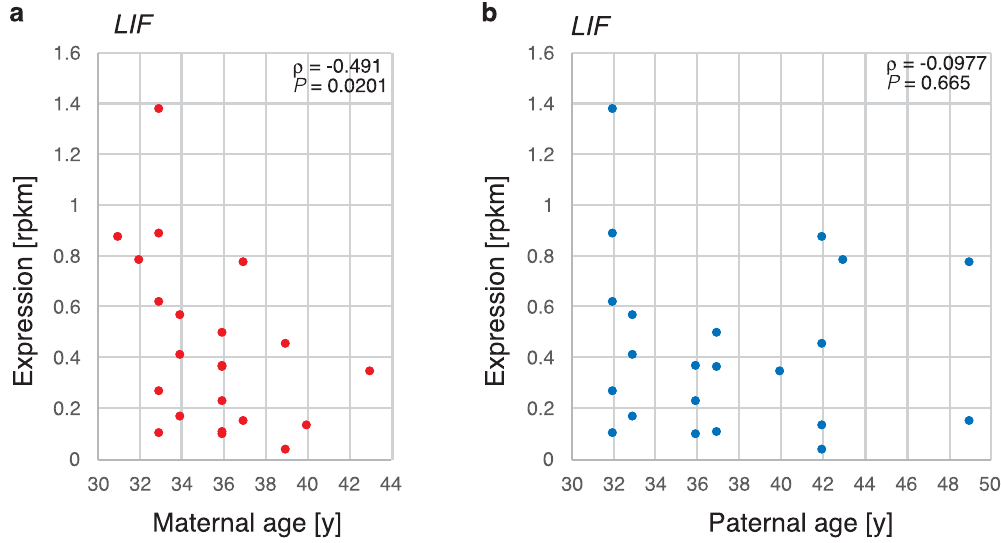
Figure 3. LIF expression according to parental age. LIF expression levels were plotted against the maternal age ( a ) or paternal age ( b